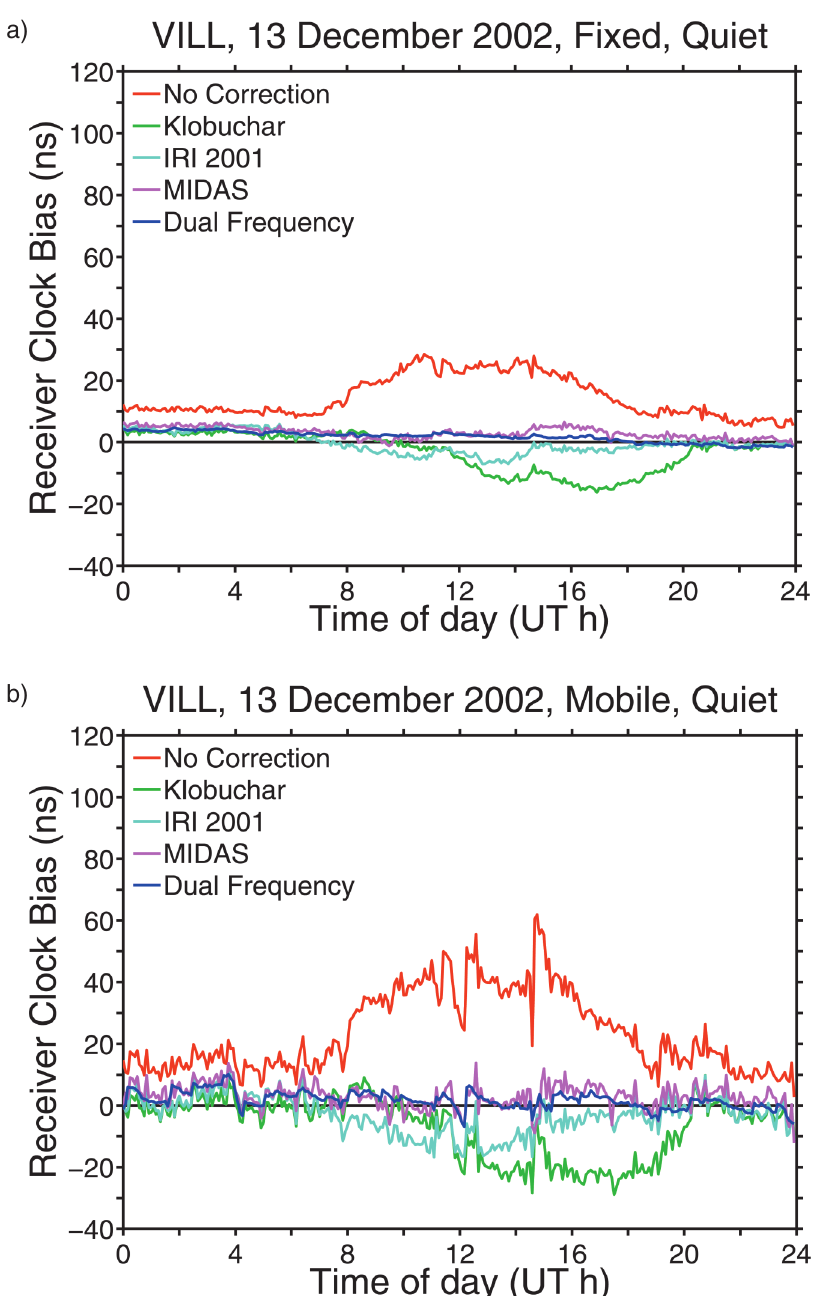
Fig. 4a,b. Receiver clock bias referenced to the receiver clock bias from CODE for VILL 13 December 2002, for a quiet ionosphere (Kp index 0.3-1.7) using a fixed (a) and mobile (b) GPS receiver solution.